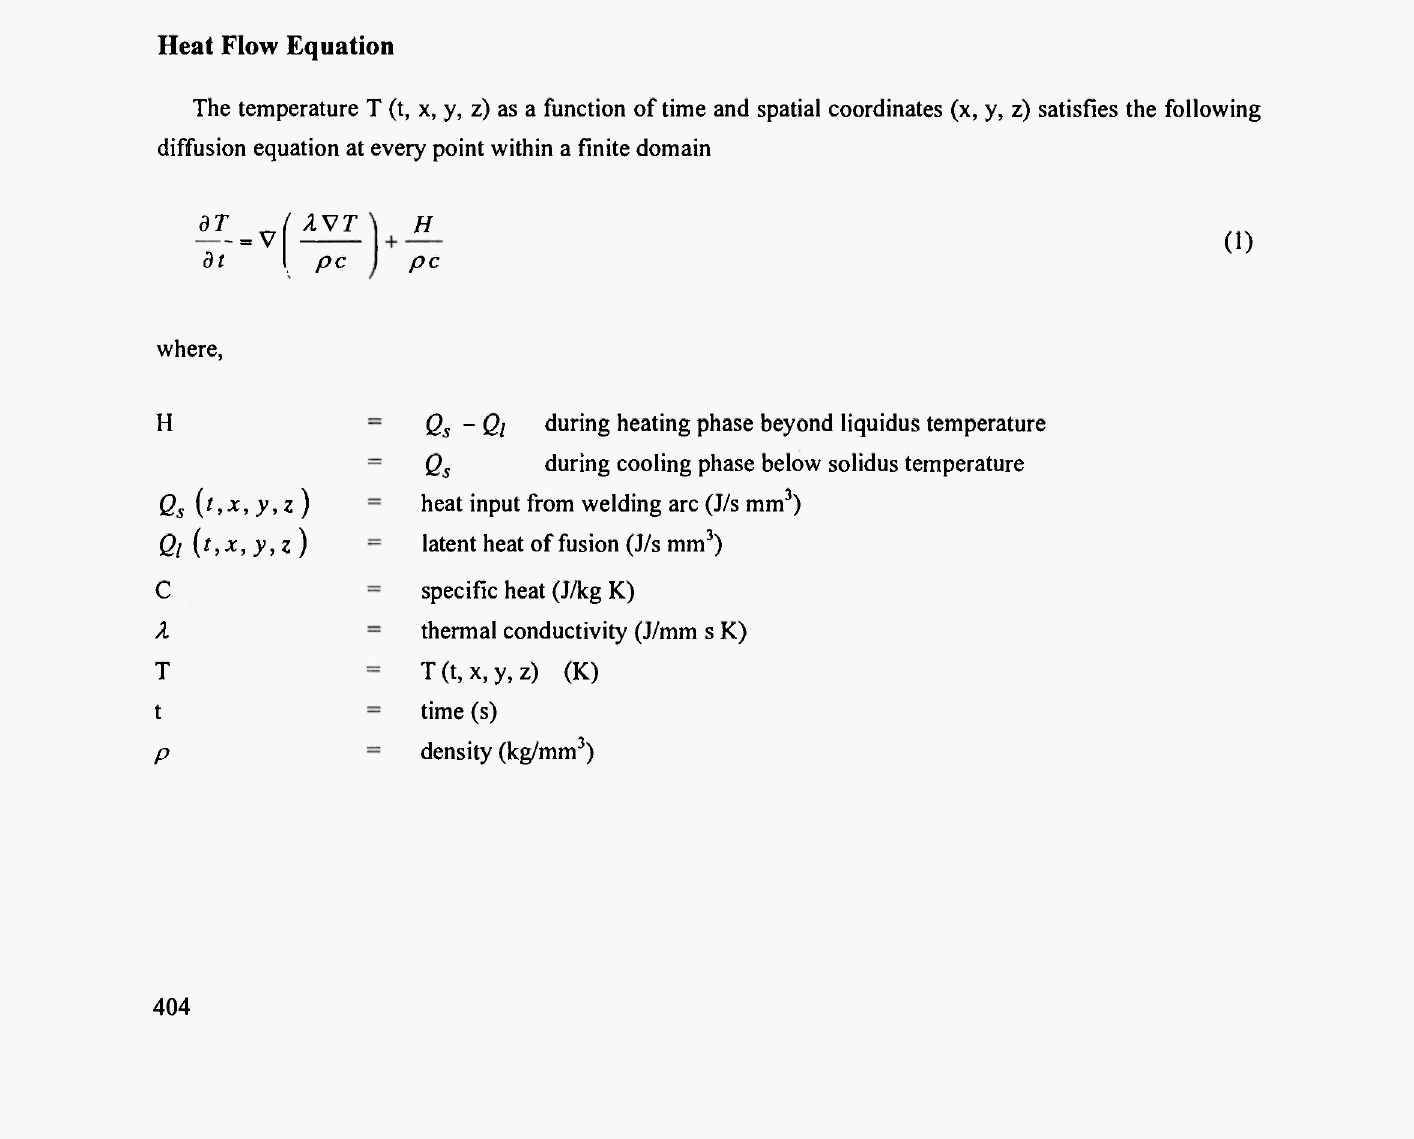
Fig. 2: Variation of thermal conductivity with